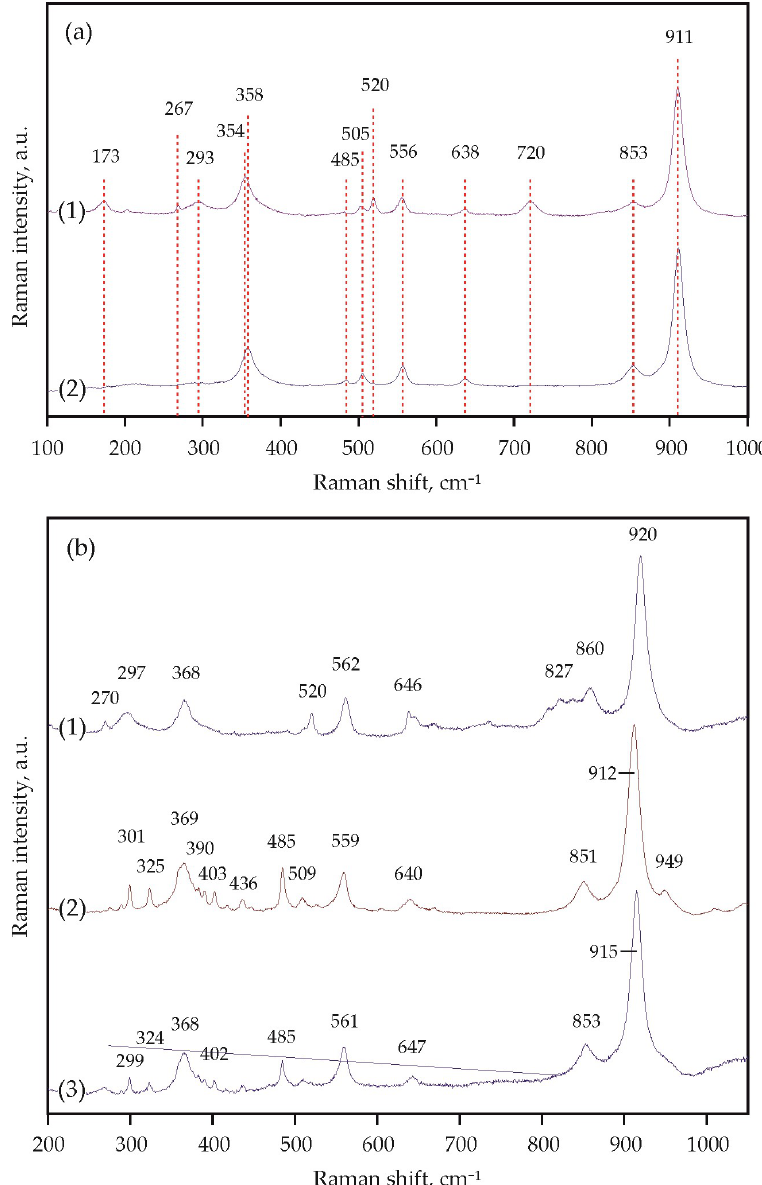
Figure 9. Representative Raman spectra of the obtained garnets: ( a ) (1)—run N 2145-A, 7.5 GPa, 1450 ◦ C, (2)—run N 2115-A, 6.3 GPa, 1300 ◦ C; ( b ) (1)—run N 2157-D, 7.5 GPa, 1550 ◦ C, (2)—run N 2155-D, 6.3 GPa, 1250 ◦ C, (3)—run N 2122-D, 3.0 GPa, 1150 ◦